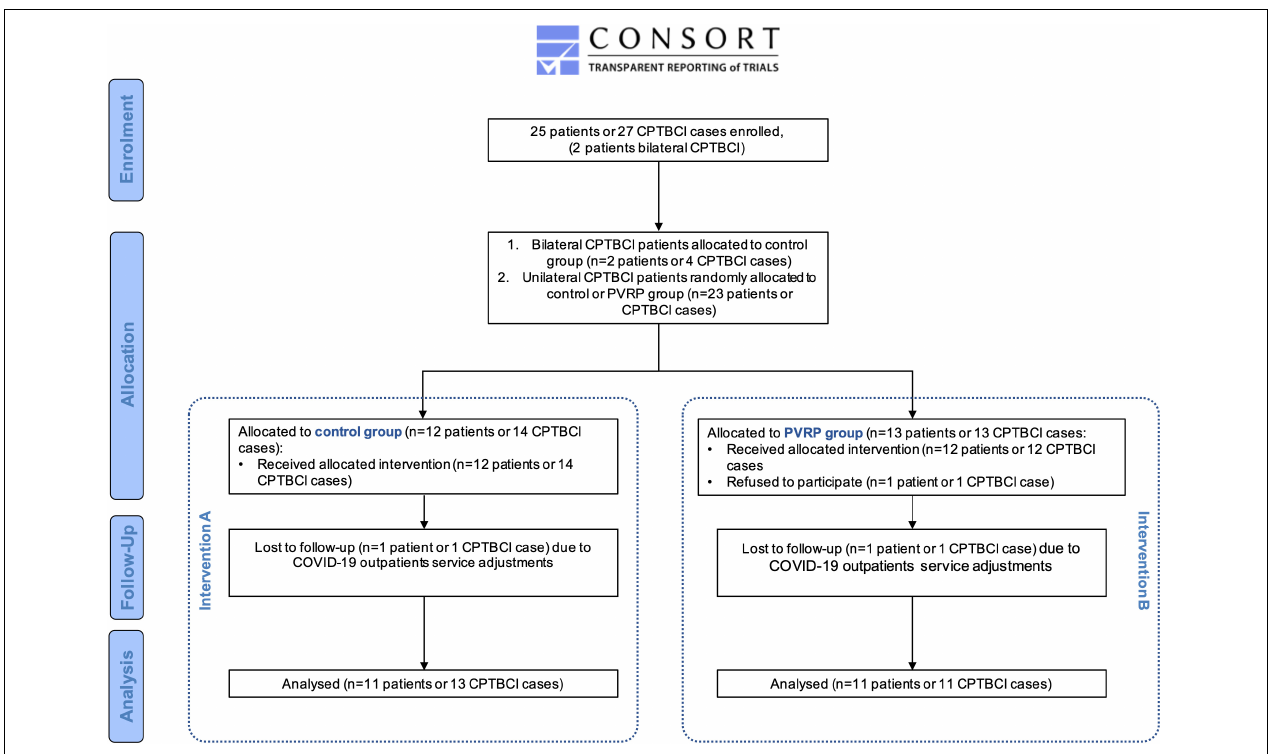
FIGURE 1 | Flowchart of a prospective randomized controlled clinical trial for treating patients with chronic postoperative temporal bone cavity inflammation. Data are presented according to the CONSORT statement (Schulz et al., 2010). Control group represented intervention A and PVRP intervention B. CPTBCI: chronic postoperative temporal bone cavity inflammation; PVRP: platelet- and extracellular vesicle-rich plasma; COVID-19: coronavirus disease